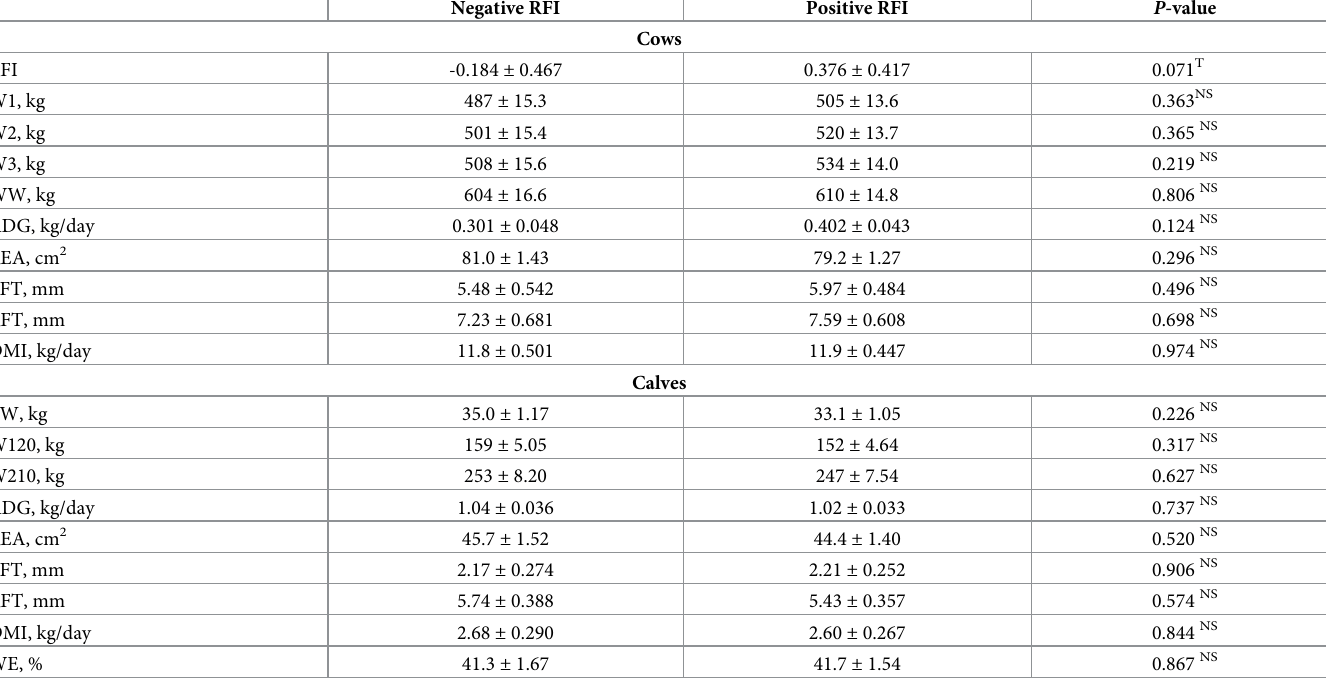
Table 6. Performance of Nellore cows of different residual feed intake (RFI) classes during the second trimester of gestation and postnatal growth of their calves in Year